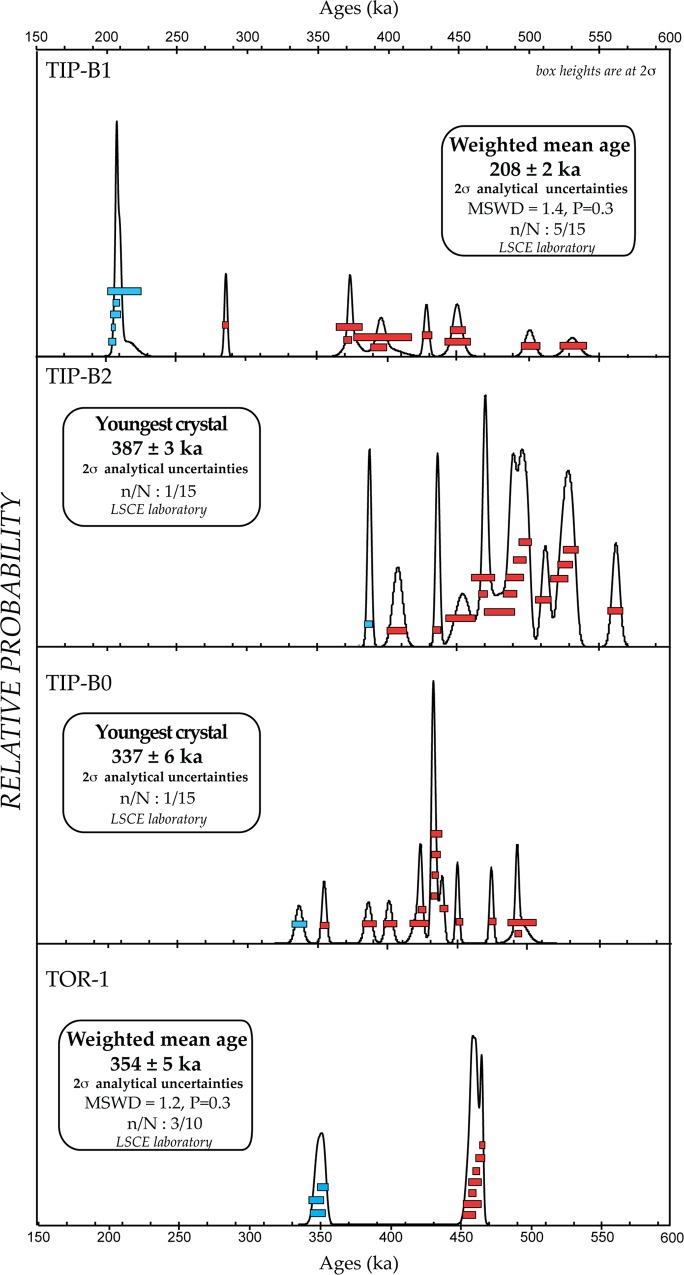
40Ar/39Ar dating.Results are presented as probability diagrams [32] for levels TOR-1, TIP-B0, TIP-B2 and TIP-B1. Each bar corresponds to the age obtained for an individual dated crystal with the corresponding analytical uncertainties at 95% of probability. MSWD = Mean Square Weighted Deviation, P = Probability fit, n/N = number of grains taken into account to calculate the weighted mean age on the total number of dated grains.